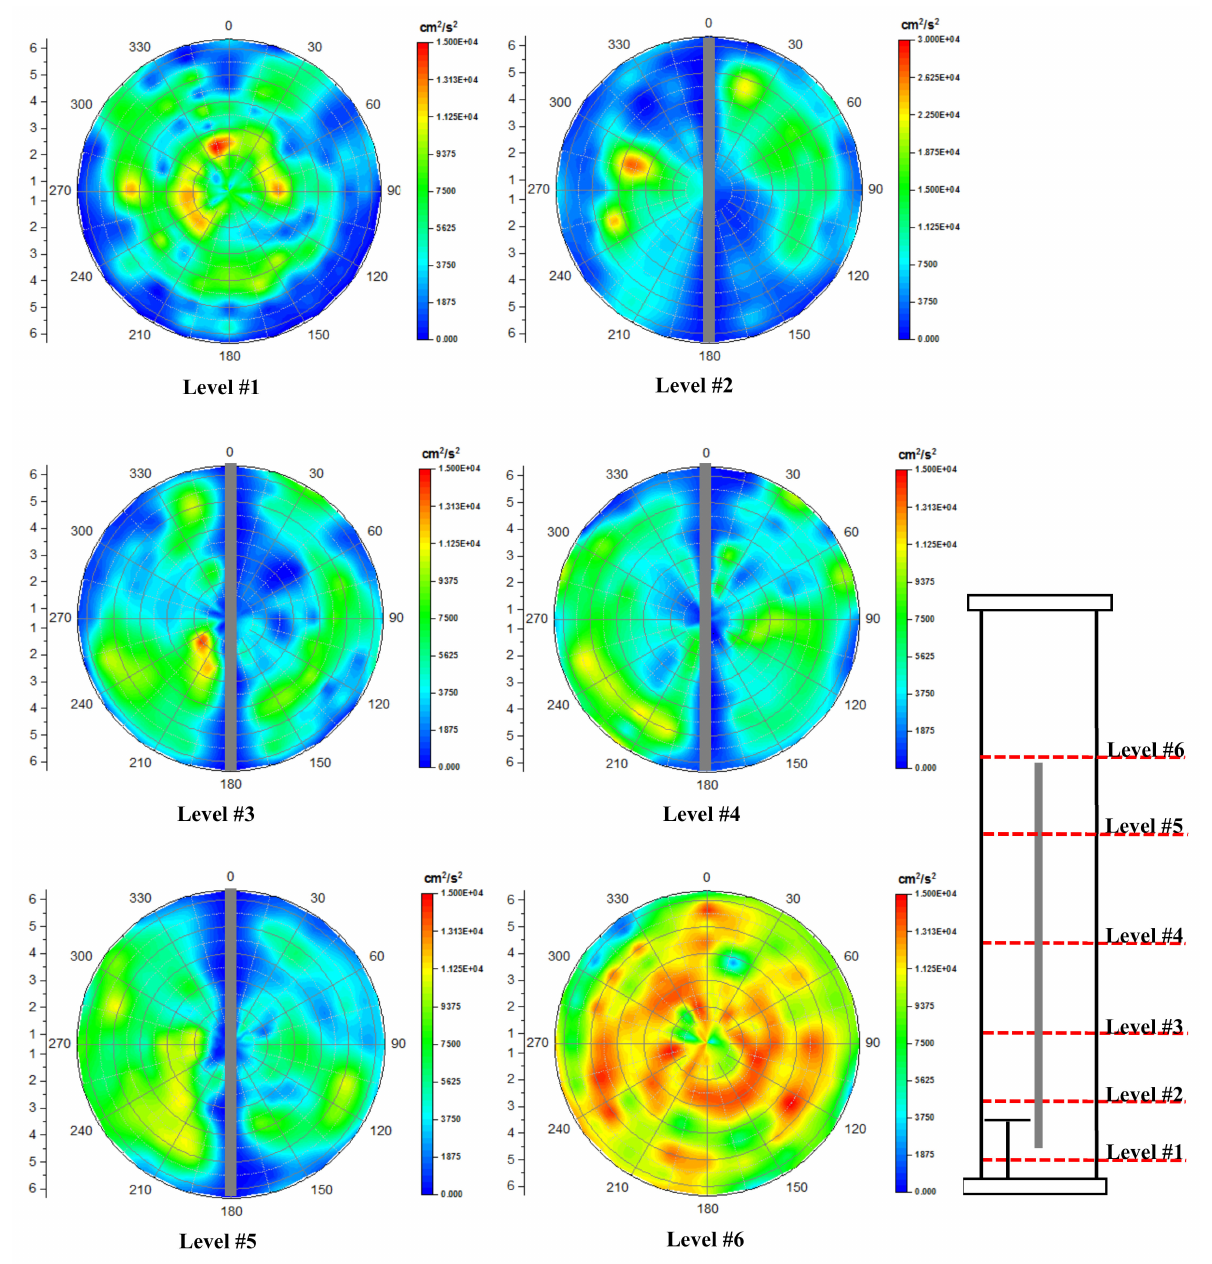
Figure 22. Cross-sectional distributions of turbulent kinetic energy at different heights of split airlift reactor operated under gas velocity of 3